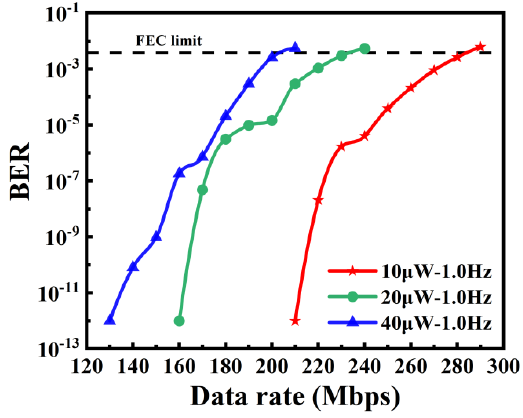
Figure 12. BER versus data rate at the different optical power variation amplitudes and same